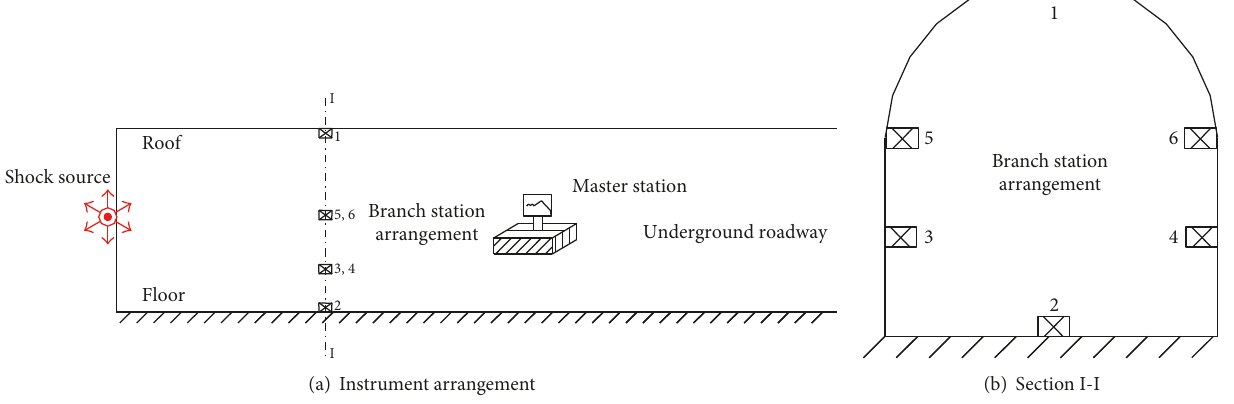
Figure 10: Test model of response characteristics at different locations on the same roadway.